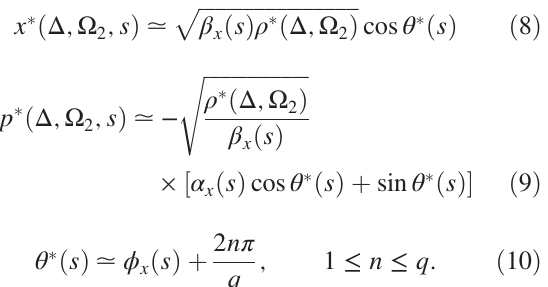
ffiffiffiffiffiffiffiffiffiffiffiffiffiffiffiffiffiffiffiffi